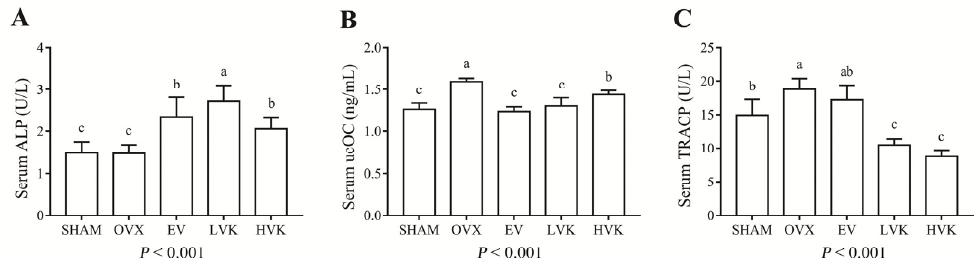
Figure 2. Serum ALP ( A ), ucOC ( B ), and TRACP ( C ) level in mice that were sham operated or ovariectomized and untreated or administered EV, LVK, or HVK for 12 wk. Values are mean ± SD, n = 8–10 per treatment. Labeled without a common letter means a significant difference, p < 0.05. ALP, alkaline phosphatase; EV, estradiol valerate; HVK; MK-4 40 mg/kg body weight group; LVK, MK-4 20 mg/kg body weight group; MK-4, menaquinone-4; OVX, ovariectomized group; SD, standard deviation; TRACP, tartrate-resistant acid phosphatase; ucOC, undercarboxylated